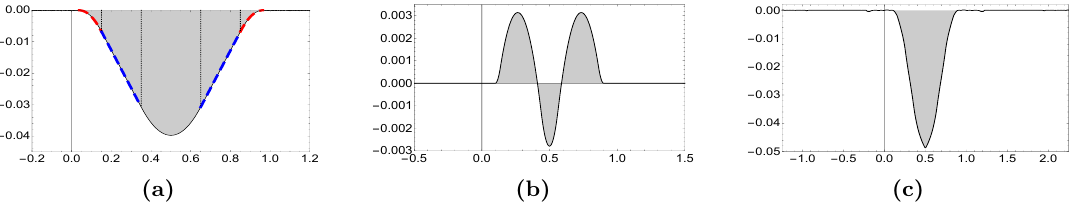
Figure 7. Numerical perturbed breather solution (shadowed region under solid line) and self- similar exact solution (dashed lines) for (cid:15) = 0 : 8. Snapshots correspond to (a) t = 0 : 15, (b) t = 0 : 44 and (c) t = 10 : 33.